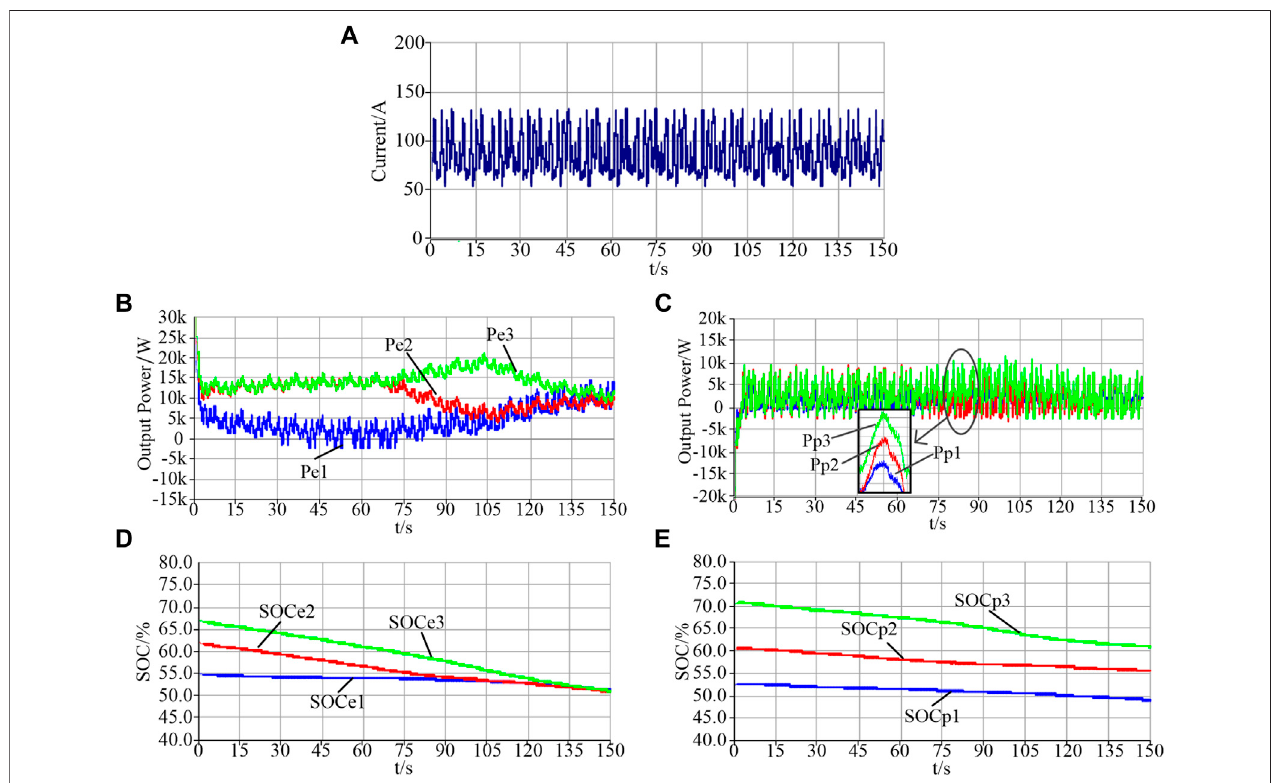
FIGURE 12 | Simulation results under random load condition: (A) Random power of renewable energy-Random output of renewable energy; (B) Output power of High-Energy Battery; (C) Output power of High-Power Battery; (D) High-Energy Battery SOC; (E) High-Power Battery SOC).